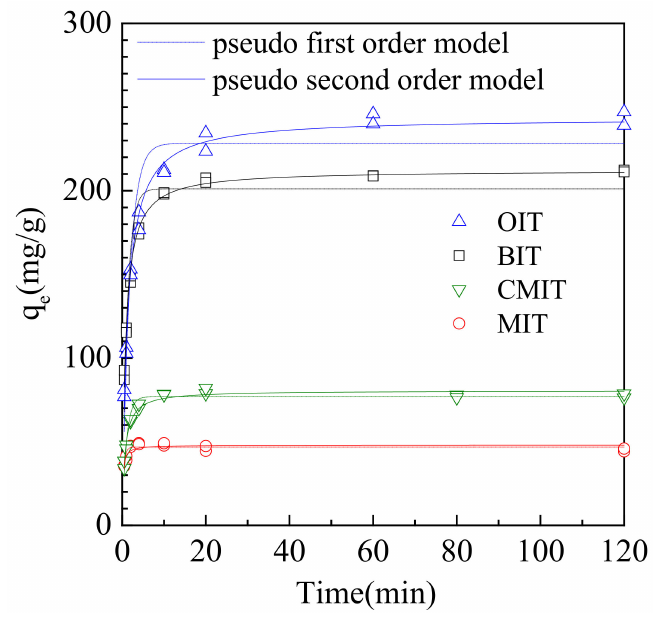
Figure 2. Kinetic adsorption curves for isothiazolones at 298 K on